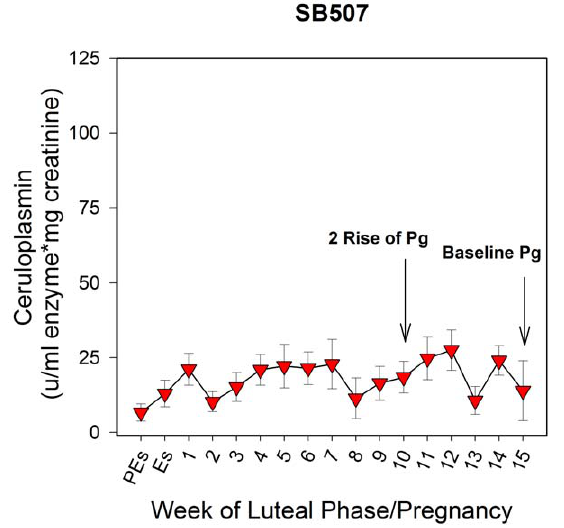
Figure 6. The levels of active ceruloplasmin in urine for a bred/ no birth cycle for female SB507: suspected pseudopregnancy/ no conception or lost pregnancy that did not elicit an immune response based on ceruloplasmin. In 2009, SB507 (MZS) was artificially inseminated but no change in the levels of active urinary ceruloplasmin was observed throughout the luteal phase and levels were similar to those observed at proestrus and estrus. Pg=Progesta- gen; PEs=Proestrus; Es=Estrus; Numerical numbers=weeks of the luteal phase. Data are weekly means 6 SEM; n=1 reproductive cycle.